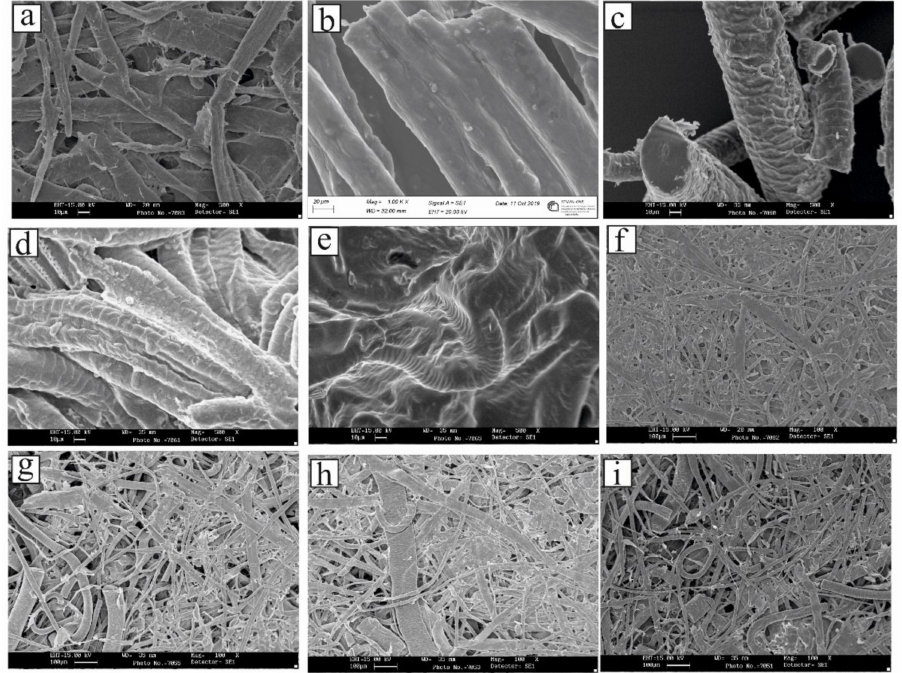
Figure 2. SEM analysis of ( a ) kraft pulp (500 × ); ( b ) raw wool (1000 × ); ( c ) 140 ◦ C hydrolyzed wool (500 × ); ( d ) 150 ◦ C hydrolyzed wool (500 × ); ( e ) 160 ◦ C hydrolyzed wool (500 × ); ( f ) control 100% kraft pulp biocomposite (100 × ); ( g ) 50%-50% kraft pulp/140 ◦ C hydrolyzed wool biocomposite (100 × ); ( h ) 50%-50% kraft pulp/150 ◦ C hydrolyzed wool biocomposite (100 × ); ( i ) 50%-50% kraft pulp/160 ◦ C hydrolyzed wool biocomposite (100 ×